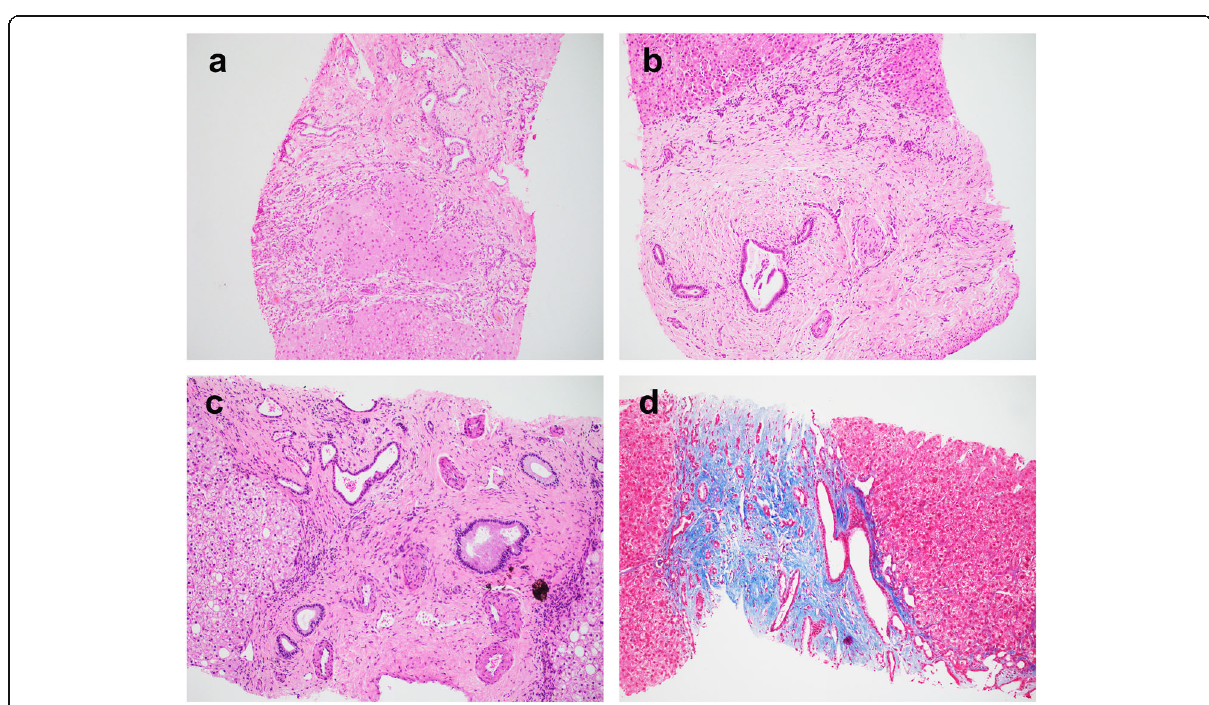
Fig. 1 Representative histology of congenital hepatic fibrosis. a Case 1. Broad fibrous bands containing abnormal bile duct profiles with anastomosing and ectasia separate the parenchyma into nodules without hepatocyte regeneration. b Case 3. The portal tract is expanded with prominent fibrosis. There are centrally located bile ducts with luminal dilatation and numerous smaller bile ducts at the limiting plate. The portal vein is hardly appreciated. c Case 9. The bile ducts are ectatic and irregular. The portal veins are small and the portal arteries are prominent and supernumerous. d Case 4. Trichrome stain highlights the portal fibrosis with embedded abnormal bile ducts. Magnification: